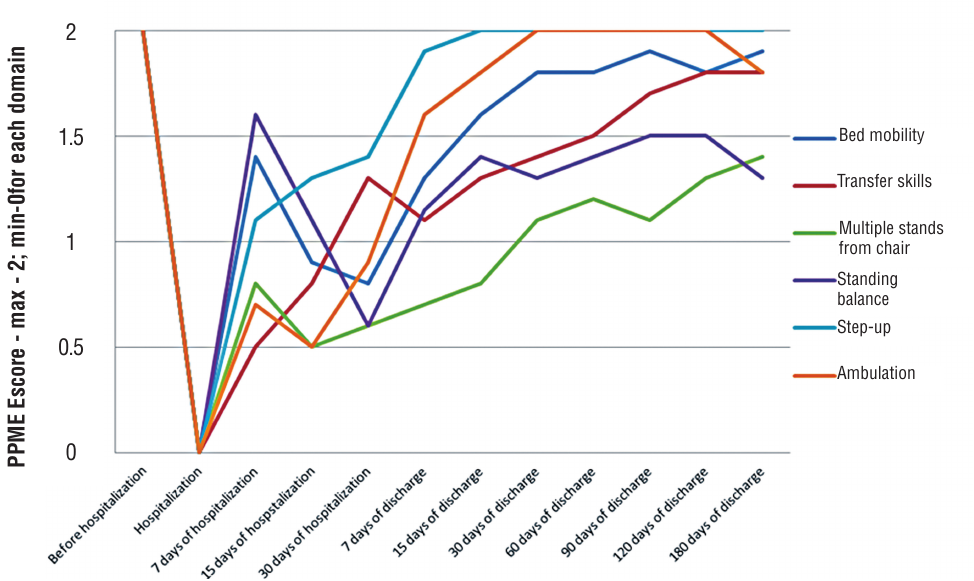
figure 3 - Evolution of ppME by each domain along 180 days of